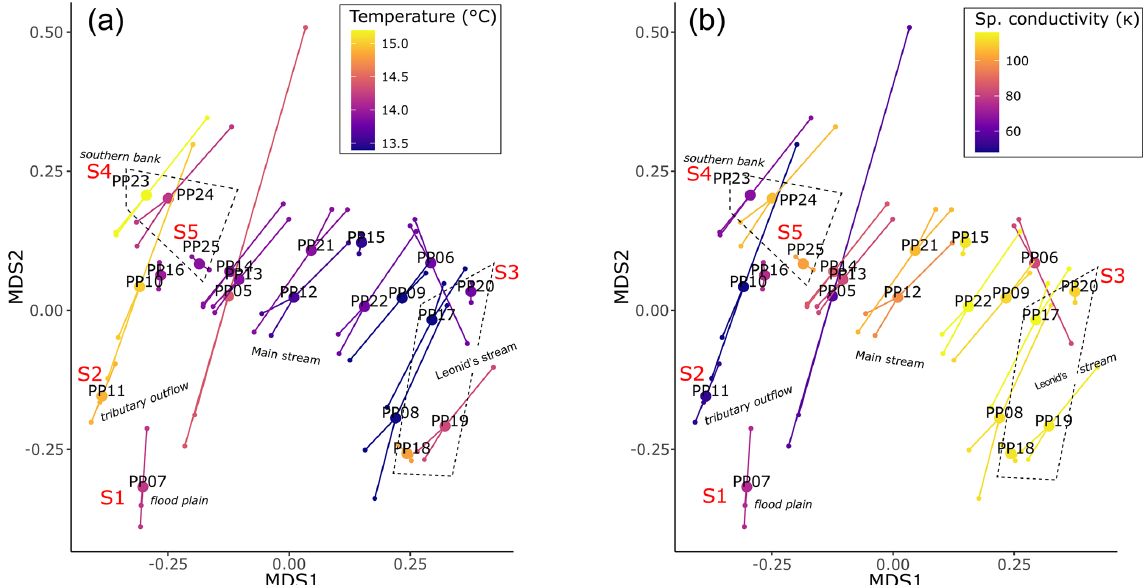
Figure 5. Riverine microbial community composition linked to temperature (a) and specific conductivity (b) . Both plots represent the same underlying community data, with dissimilarities determined by the Bray–Curtis metric and visualized with non-metric multidimensional scaling plots.